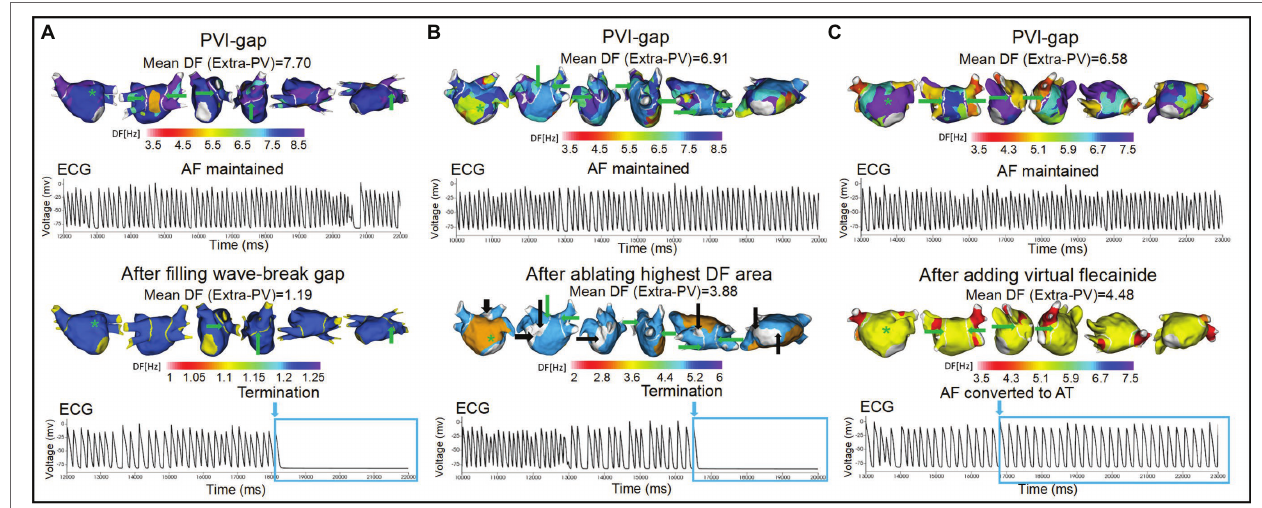
FIGURE 5 | Wave-dynamic changes after filling the wave-breaking PVI-gaps, ablating the highest DF sites, and adding virtual flecainide. ECGs were obtained at the green * sites in the DF map, and the green arrows indicate the gaps in the PVI. (A) AF terminated after ablating the two gaps on the posterior wall of the LA. (B) AF terminated after ablating the high DF site (white areas indicated by black arrows). (C) AF converted to AT after adding virtual flecainide without additional ablation. PVI-gap indicates pulmonary vein isolation with gaps; PV, pulmonary vein; DF, dominant frequency; AF, atrial fibrillation; AT, atrial tachycardia; ECG, Electrocardiogram.